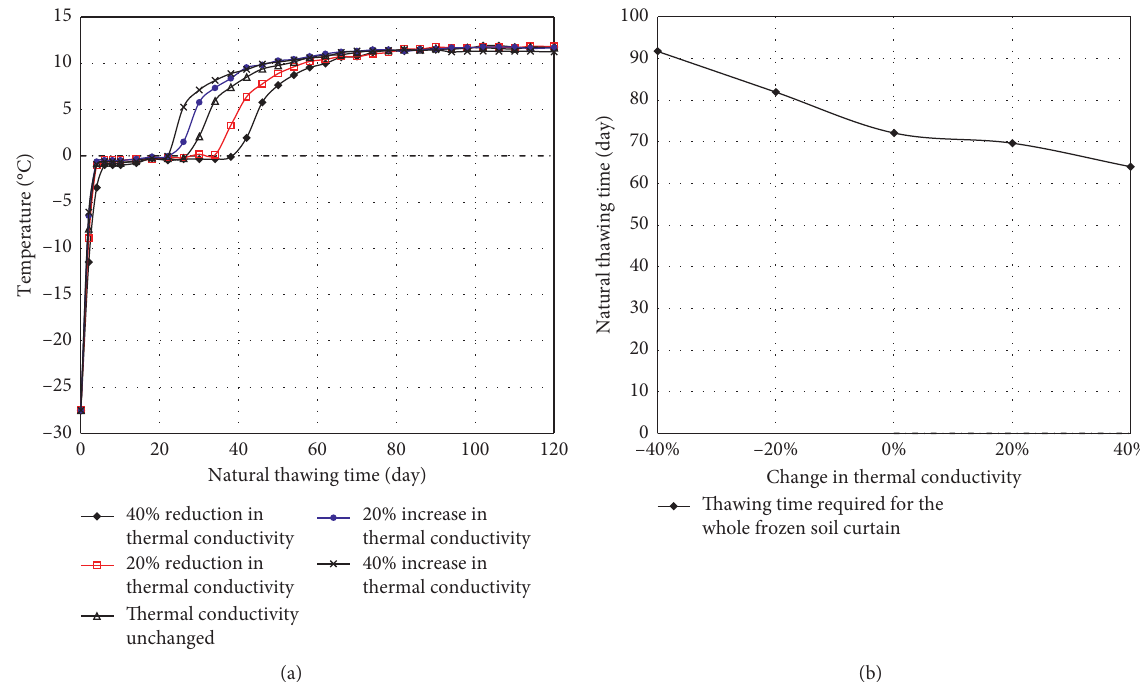
Figure 13: Effects of thermal conductivity on the temperature-thawing time response and required thawing time for frozen soil curtain: (a) temperature-thawing time response at X � 3m (monitor point 2); (b) variation of required thawing time with thermal conductivity